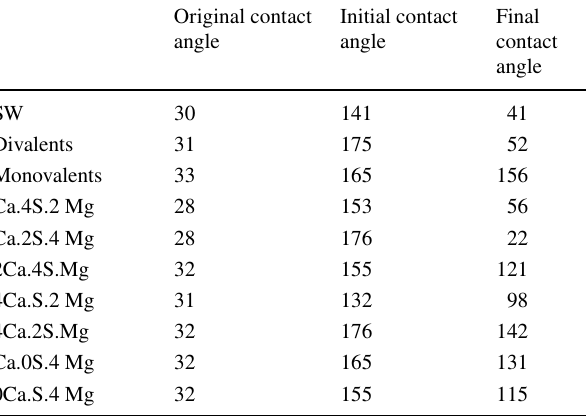
Fig. 2 Schematic of core flood apparatus Table 3 Performed scenario(s) in each test Table 5 Measured contact angle at 4000 psia and 90 °C after 360